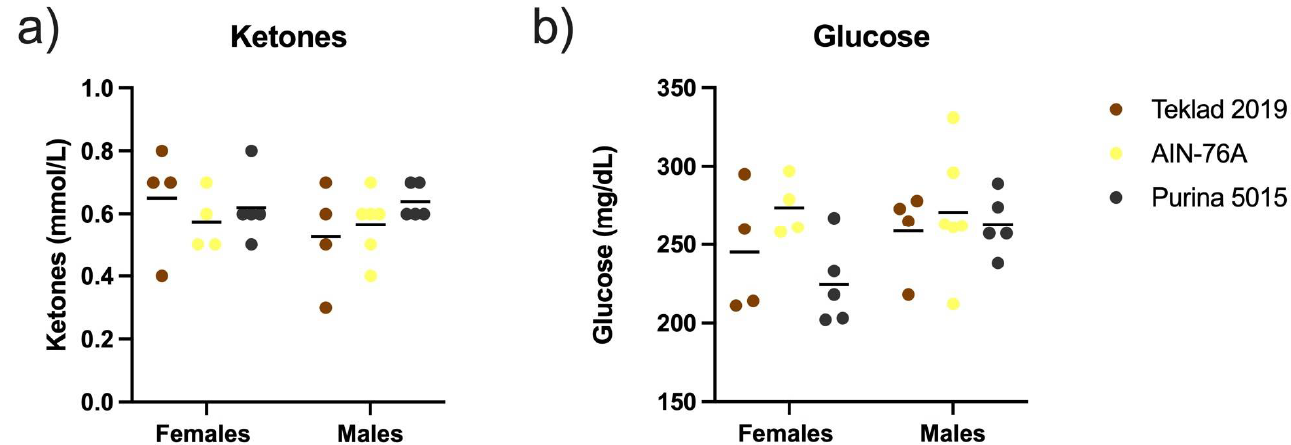
Figure 5. Plasma biochemistry as an effect of diet. Blood was collected from male and female C57BL/6J mice at euthanization and quantitated for plasma ketone and glucose levels as an effect of diet (Teklad 2019, AIN-76A or Purina 5015). Statistics were determined by 2-way ANOVA and Tukey’s multiple comparison tests with no significant differences. ( a ) ketones ( n = 4–5 females and n = 4–6 males per diet); ANOVA results: interaction F(2, 22) = 0.8778, p = 0.43; sex F(1, 22) = 0.6742, p = 0.4204; and diet F(2,22) = 0.6284, p = 0.54. ( b ) glucose ( n = 4–5 females and n = 4–6 males per diet); ANOVA results: interaction F(2, 22) = 1.142, p = 0.34; sex F(1, 22) = 1.963, p = 0.18; and diet F(2, 22) = 2.251, p =